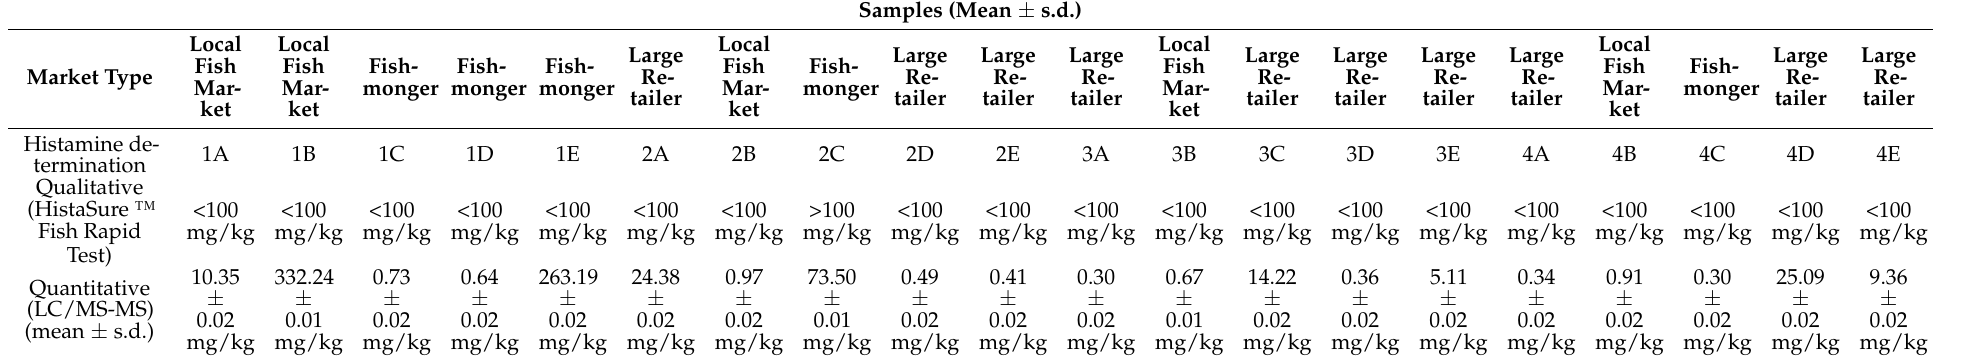
Table 7. Qualitative and quantitative determination of histamine in of yellowfin tuna samples included in the study. Samples (Mean ± s.d.)